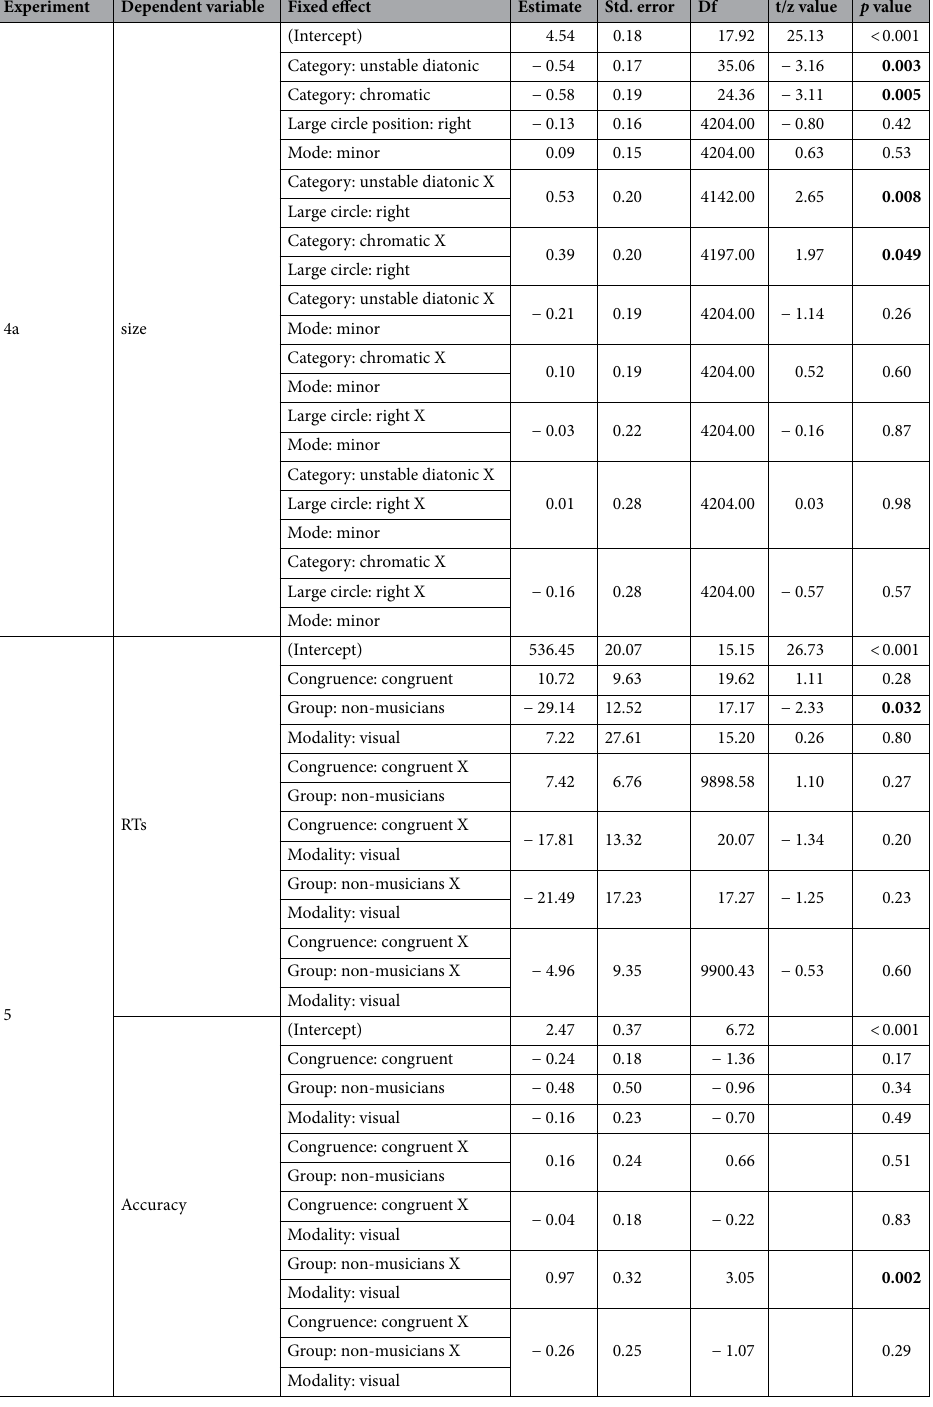
Table 3. Fixed effects results in Experiments 4, 4A and 5. Bold values represent significant fixed effects or interactions.Bold values represent significant fixed effects or